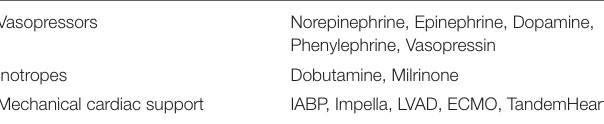
TABLE 1 | Clinical interventions often applied to patients with